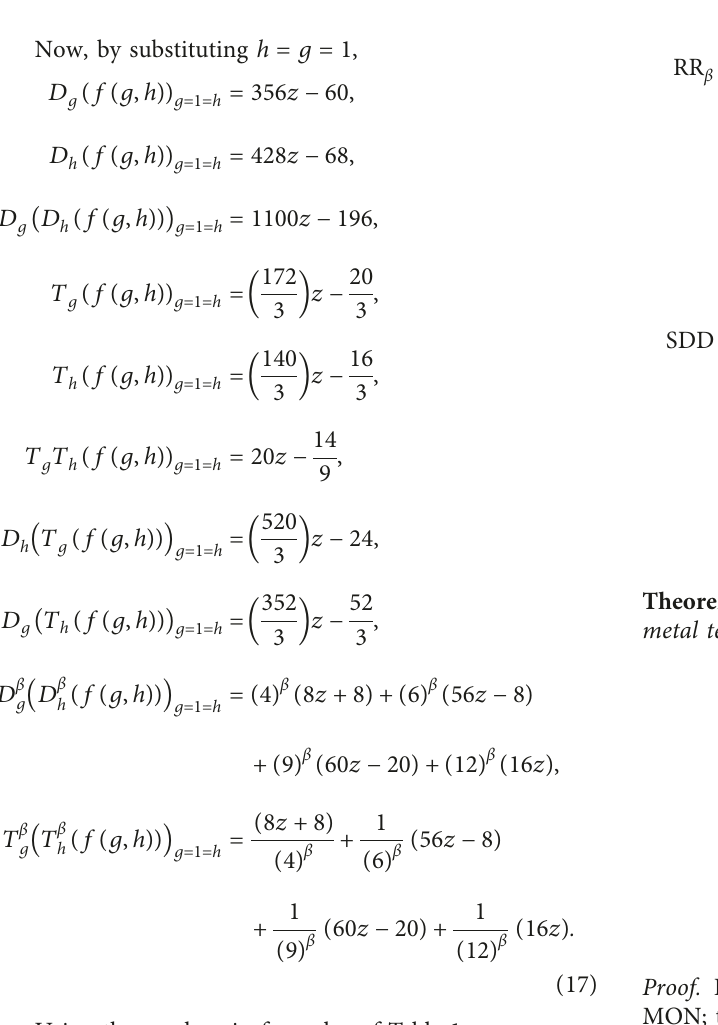
Figure 3: Transition metal tetra-cyano-benzene organic network